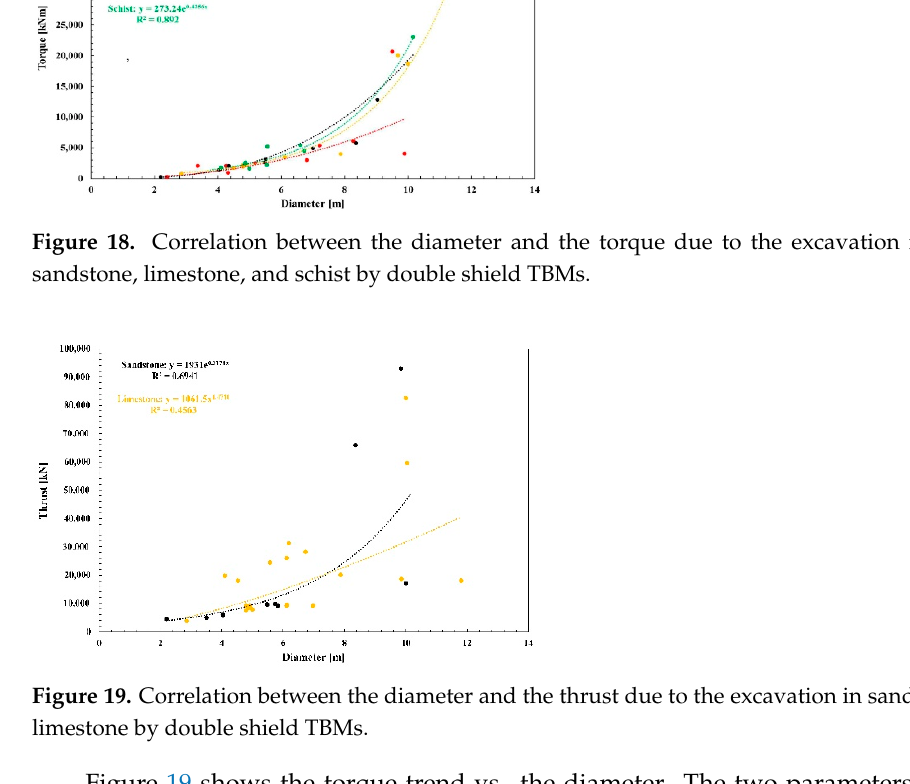
Figure 19. Correlation between the diameter and the thrust due to the excavation in sandstone and limestone by double shield TBMs.